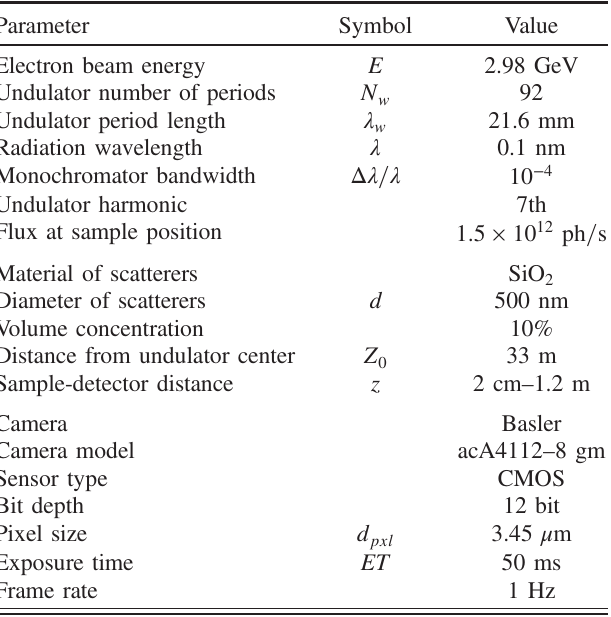
TABLE I. Main parameters of the HNFS setup installed at the NCD-SWEET beamline at